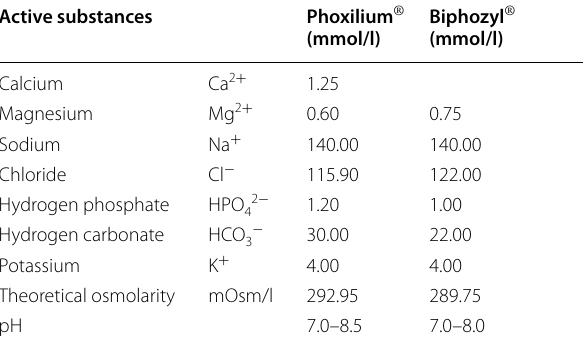
Table 1 Comparison of the composition of the reconstituted